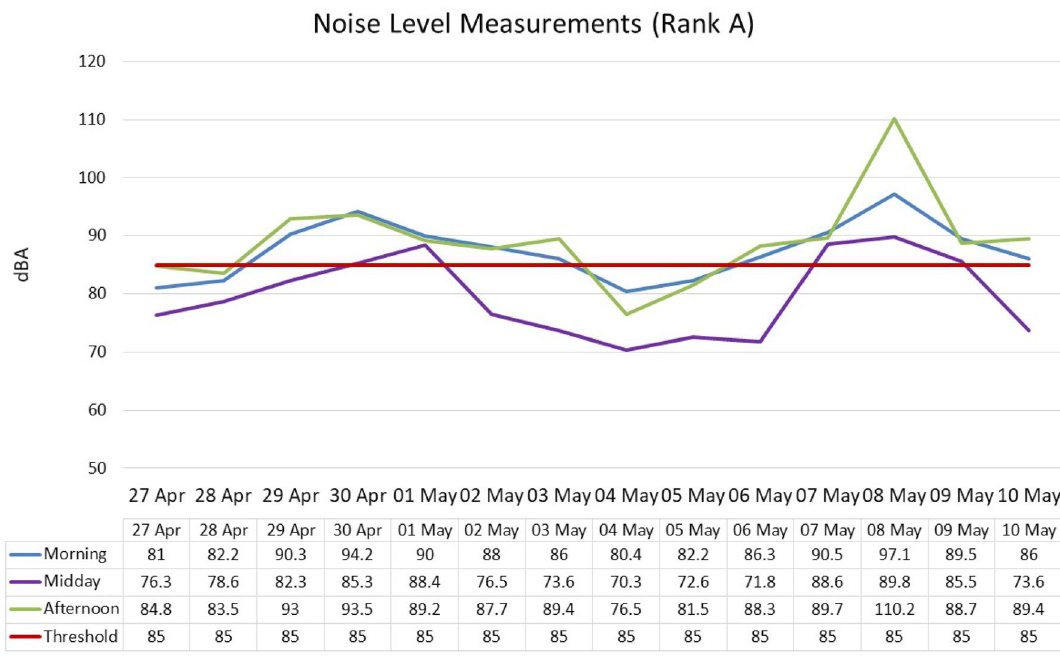
Figure 1. Noise level measurement: Rank A (Open).